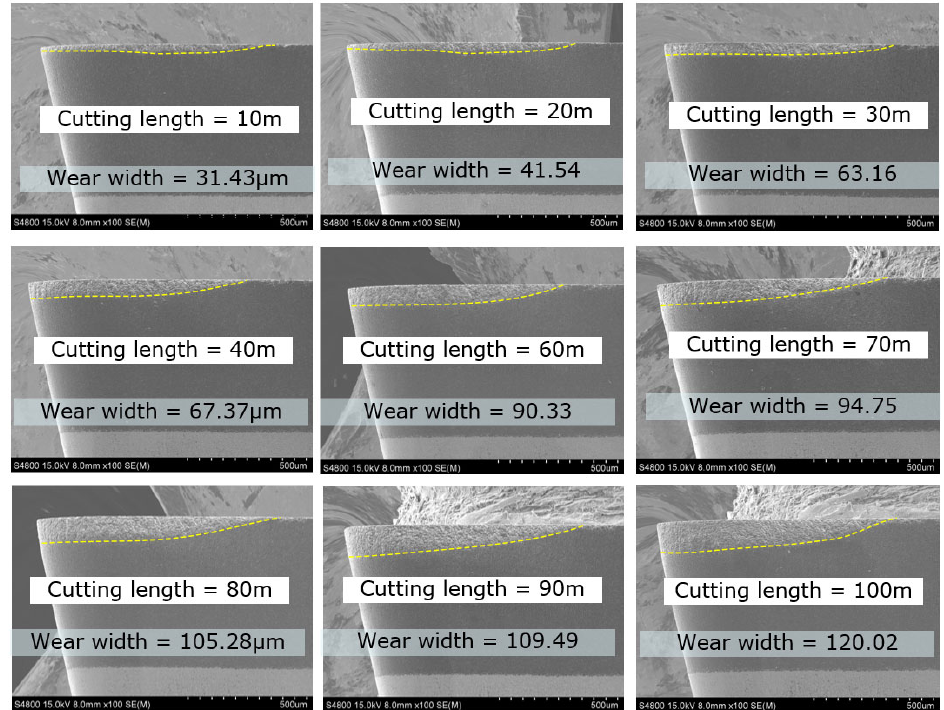
Figure 7. flank face wear width at different cutting lengths. Figure 7. Flank face wear width at different cutting